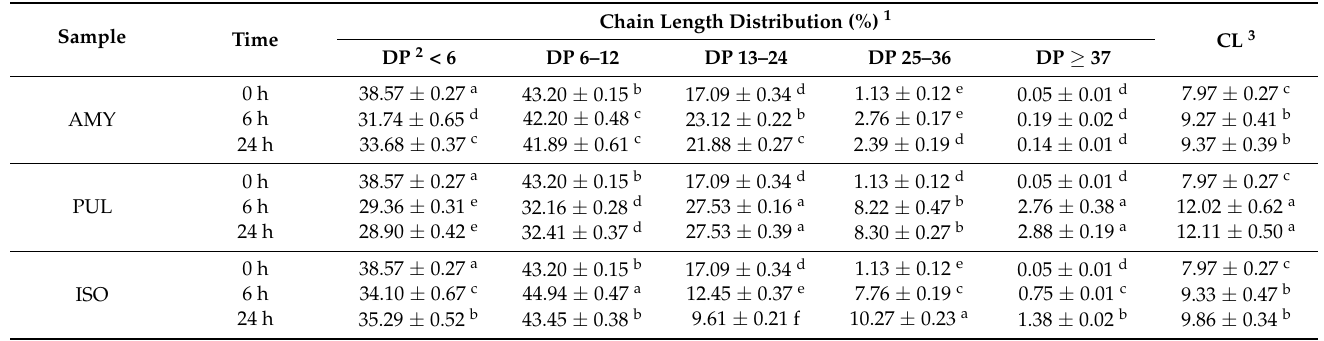
Table 2. Chain length distribution of hydrolysates was obtained by debranching DE6 maltodextrin with AMY, PUL, and ISO,